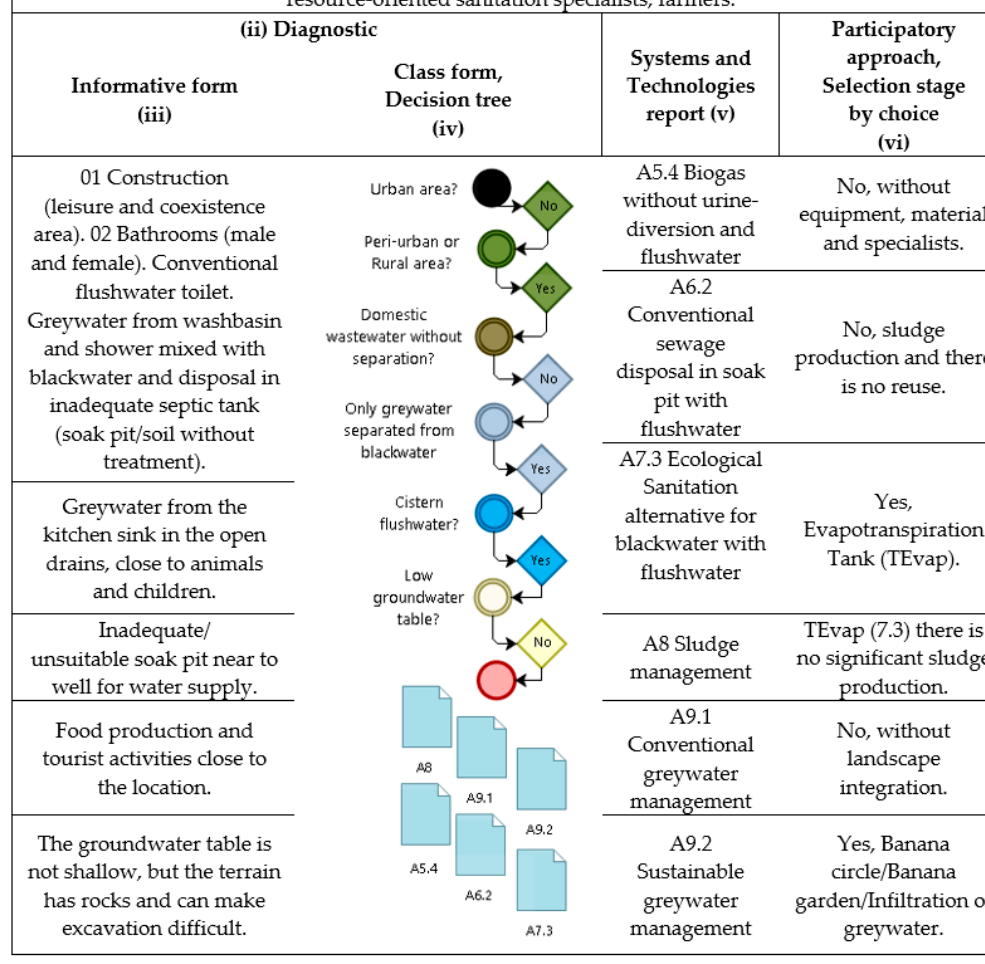
Figure 3. Stakeholder’s identification, diagnostic, decision tree, sanitation systems and participatory approach.